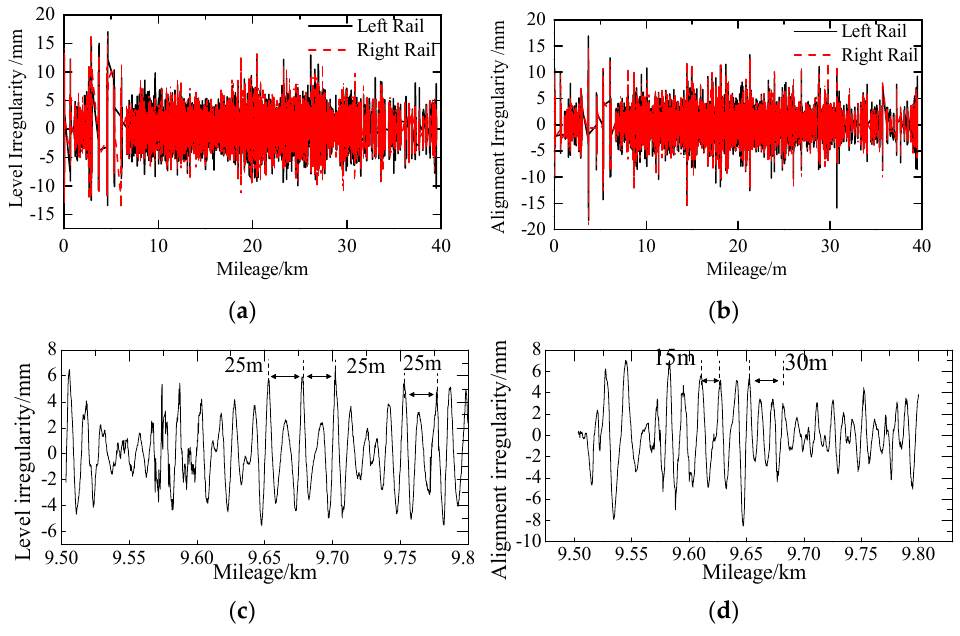
Figure 1. The time-domain characteristics of the track geometries: ( a ) the time-history diagram of level irregularity; ( b ) the time-history diagram of alignment irregularity; ( c ) the feature of the level irregularity; ( d ) the feature of the alignment irregularity.